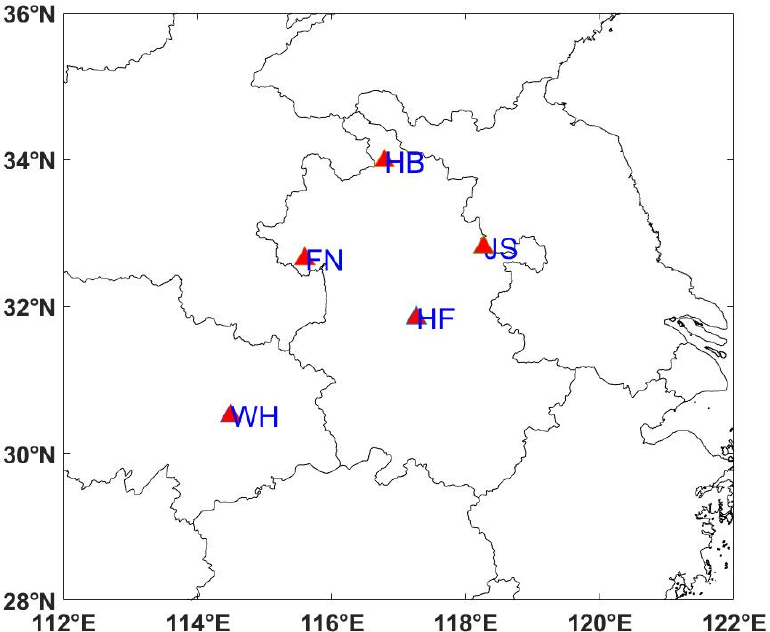
Figure 3. Layout of stations in the Jianghuai Area Sferic Array. The distance between the HF station and the JS station is 142 km.